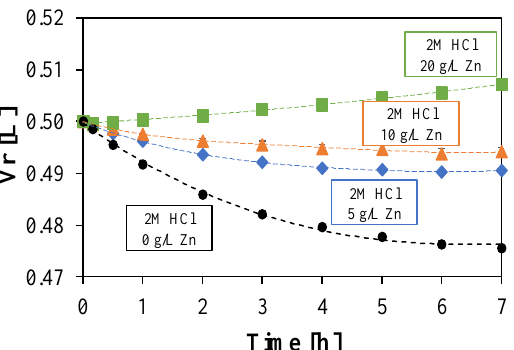
Time [h] Figure 3. Trend over time of the retentate tank volume. Initial Zn conc.: 0 ( Figure 3. Trend over time of the retentate tank volume. Initial Zn conc.: 0 ( ); 5 ( ♦ ), 10 ( ) and Figure 3. Trend over time of the retentate tank volume. Initial Zn conc.: 0 ( ); 5 ( ♦ ), 10 ( ) and Figure 3. Trend over time of the retentate tank volume. Initial Zn conc.: 0 ( ); 5 ( ♦ ), 10 ( ) and Figure 3. Trend over time of the retentate tank volume. Initial Zn conc.: 0 ( ); 5 ( ♦ ), 10 ( ) and Figure 3. Trend over time of the retentate tank volume. Initial Zn conc.: 0 ( ); 5 ( ♦ ), 10 ( ) and Figure 3. Trend over time of the retentate tank volume. Initial Zn conc.: 0 ( ); 5 ( ♦ ), 10 ( ) and Figure 3. Trend over time of the retentate tank volume. Initial Zn conc.: 0 ( ); 5 ( ♦ ), 10 ( ) and Figure 3. Trend over time of the retentate tank volume. Initial Zn conc.: 0 ( ); 5 ( ♦ ), 10 ( ) and ) g / L. Initial HCl concentration: 73 g / L (2 mol / L). Solutions flow rate fixed at 48 mL / min. Feed solution: 20 ( ) g/L. Initial HCl concentration: 73 g/L (2 mol/L). Solutions flow rate fixed at 48 mL/min. Figure 3. Trend over time of the retentate tank volume. Initial Zn conc.: 0 ( ); 5 ( ♦ ), 10 ( ) and 20 20 ( ) g/L. Initial HCl concentration: 73 g/L (2 mol/L). Solutions flow rate fixed at 48 mL/min. 20 ( ) g/L. Initial HCl concentration: 73 g/L (2 mol/L). Solutions flow rate fixed at 48 mL/min. 20 ( ) g/L. Initial HCl concentration: 73 g/L (2 mol/L). Solutions flow rate fixed at 48 mL/min. Figure 3. Trend over time of the retentate tank volume. Initial Zn conc.: 0 ( ); 5 ( ♦ ), 10 ( ) and 20 20 ( ) g/L. Initial HCl concentration: 73 g/L (2 mol/L). Solutions flow rate fixed at 48 mL/min. 20 ( ) g/L. Initial HCl concentration: 73 g/L (2 mol/L). Solutions flow rate fixed at 48 mL/min. 20 ( ) g/L. Initial HCl concentration: 73 g/L (2 mol/L). Solutions flow rate fixed at 48 mL/min. ( ) g/L. Initial HCl concentration: 73 g/L (2 mol/L). Solutions flow rate fixed at 48 mL/min. HCl + ZnCl 2 . Inlet di ff usate: deionized water. Batch Feed solution: HCl + ZnCl 2 . Inlet diffusate: deionized water. Batch experimental-set-up. ( ) g/L. Initial HCl concentration: 73 g/L (2 mol/L). Solutions flow rate fixed at 48 mL/min. Feed Feed solution: HCl + ZnCl 2 . Inlet diffusate: deionized water. Batch experimental-set-up. Feed solution: HCl + ZnCl 2 . Inlet diffusate: deionized water. Batch experimental-set-up. Feed solution: HCl + ZnCl 2 . Inlet diffusate: deionized water. Batch experimental-set-up. ( ) g/L. Initial HCl concentration: 73 g/L (2 mol/L). Solutions flow rate fixed at 48 mL/min. Feed Feed solution: HCl + ZnCl 2 . Inlet diffusate: deionized water. Batch experimental-set-up. Feed solution: HCl + ZnCl 2 . Inlet diffusate: deionized water. Batch experimental-set-up. Feed solution: HCl + ZnCl 2 . Inlet diffusate: deionized water. Batch experimental-set-up. Feed solution: HCl + ZnCl 2 . Inlet diffusate: deionized water. Batch experimental-set-up. solution: HCl + ZnCl 2 . Inlet diffusate: deionized water. Batch experimental-set-up. solution: HCl + ZnCl 2 . Inlet diffusate: deionized water. Batch experimental-set-up.